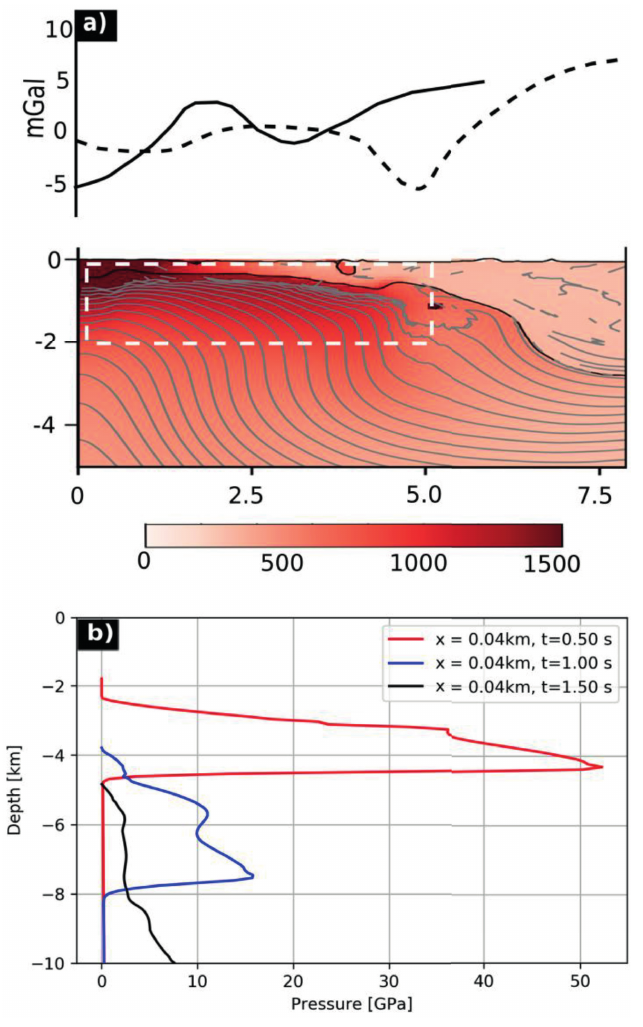
Figure 6. (a) Last timeframe obtained by iSALE showing the temperature range (in K) within a 7.5 km radius. The dashed white line corresponds to the same area (5 km x 2 km) of the gravity inversion presented in Figure 4. The temperature peaks in this area are likely related to the formation of melts in the granite. The upper fi gure shows the Bouguer anomaly estimated by the porosity model (dashed line) and the real Bouguer anomaly obtained from Figure 2 in the E-W direction. (b) Linear downward pressure trend at the innermost center. The pressure peak is around 53 GPa after 0.5 s, falling to 15 GPa after 1 s, and to less than 10 GPa after 1.5